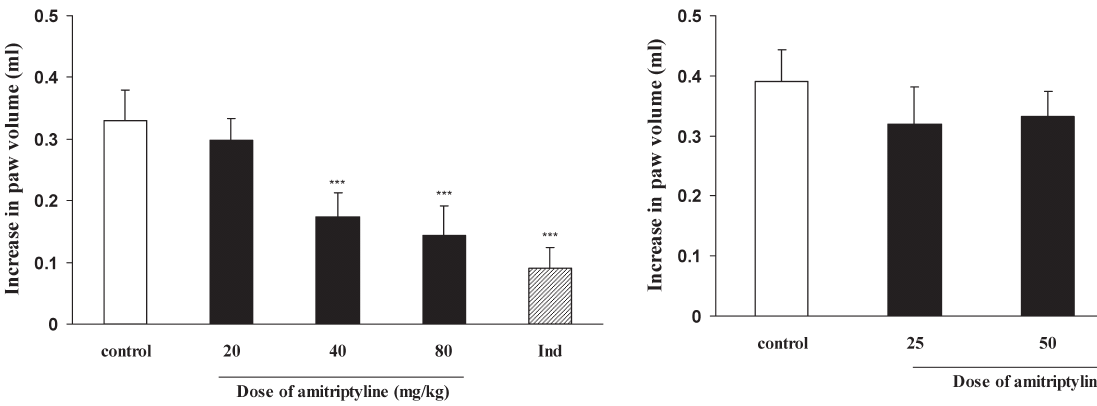
Figure 3 - Lack of effect of intrathecal injection of amitriptyline on carrageenan-induced paw edema in the rats. Amitriptyline or the vehicle was administrated intrathecally 30 min prior to carrageenan (1%) injection, and the rats were evaluated for paw